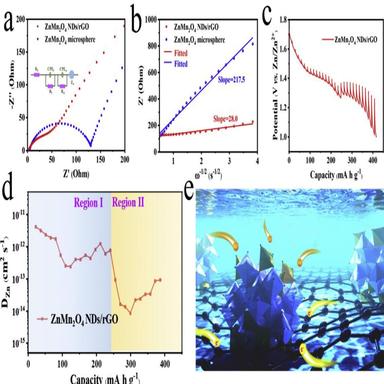
(a) Nyquist plots for the ZnMn2O4 NDs/rGO composite and pure ZnMn2O4 microspheres. (b) Relation of Z′–ω−1/2 curves in the low-frequency region for the ZnMn2O4 NDs/rGO and pure ZnMn2O4 microsphere. (c) GITT curves and (d) calculated Zn2+ diffusion coefficient of ZnMn2O4 NDs/rGO and pure ZnMn2O4 microsphere electrodes during the discharge process. (e) Schematic illustration of electrochemical performance of the strongly coupled ZnMn2O4 NDs/rGO composite.